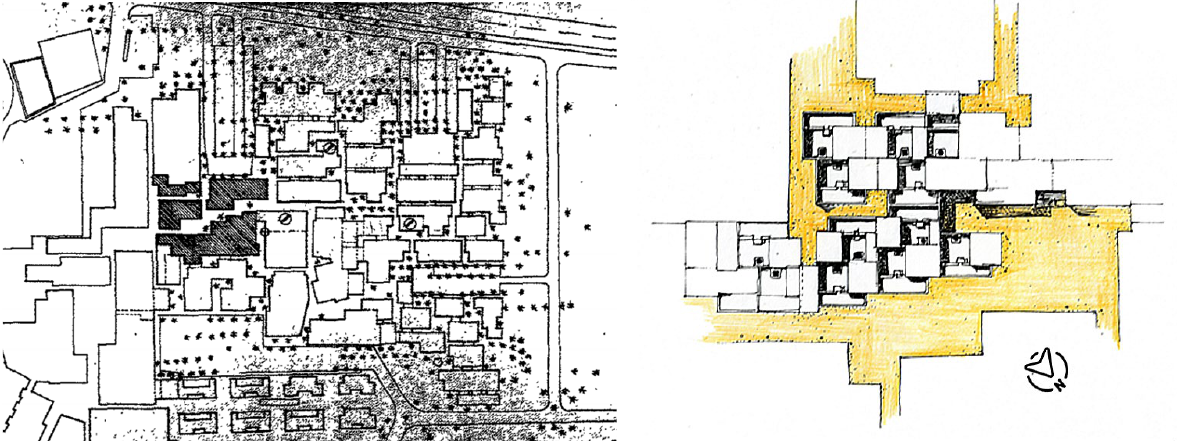
Figure 2. Site location of Sidi Abbaz housing project ( left ) and the dwellings settlement ( right ) [44,46]. The Sidi Abbaz neo-vernacular dwellings are designed by referring to the